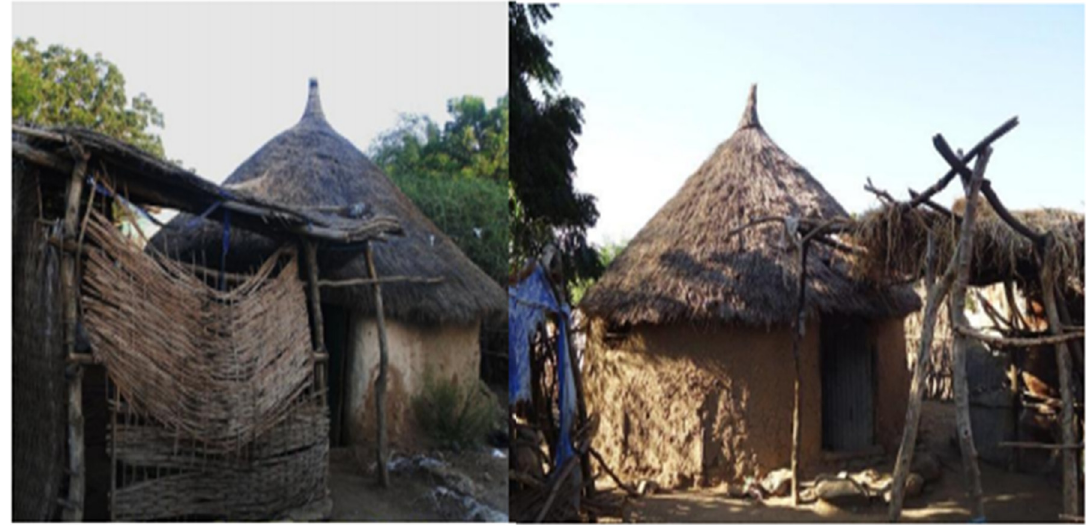
Figure 8. Basket shelter attachments .